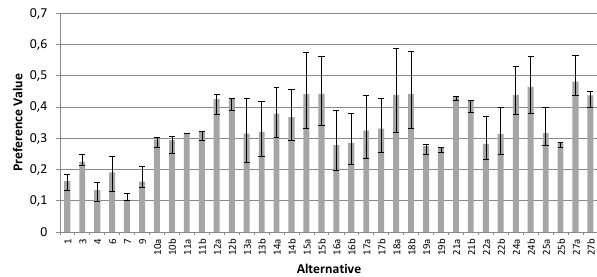
Figure 9. Preference values of stakeholder group “Ecologists” (bars) and fluctuation range due to different valuations of attributes within the stakeholder group.